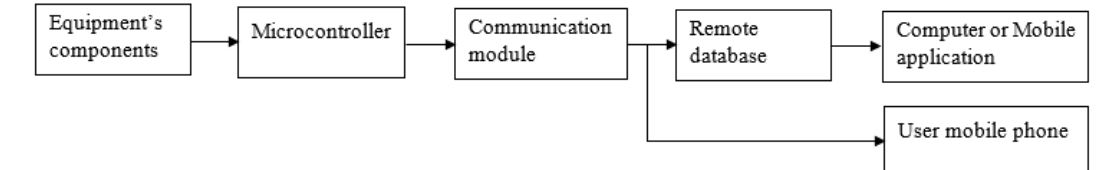
Figure 9. Proposed PdM Structure bloc